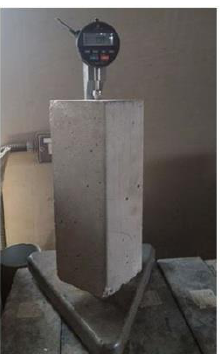
Figure 4. Total shrinkage of the prismatic specimen measured by length comparator.